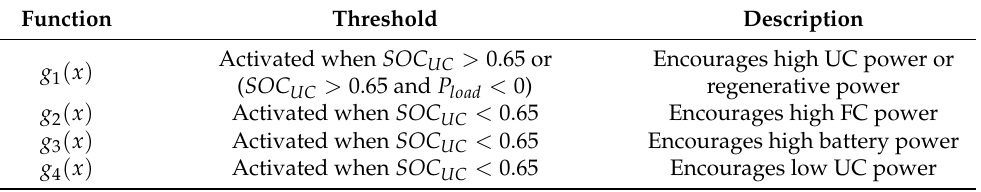
Table 7. Shaped reward functions.